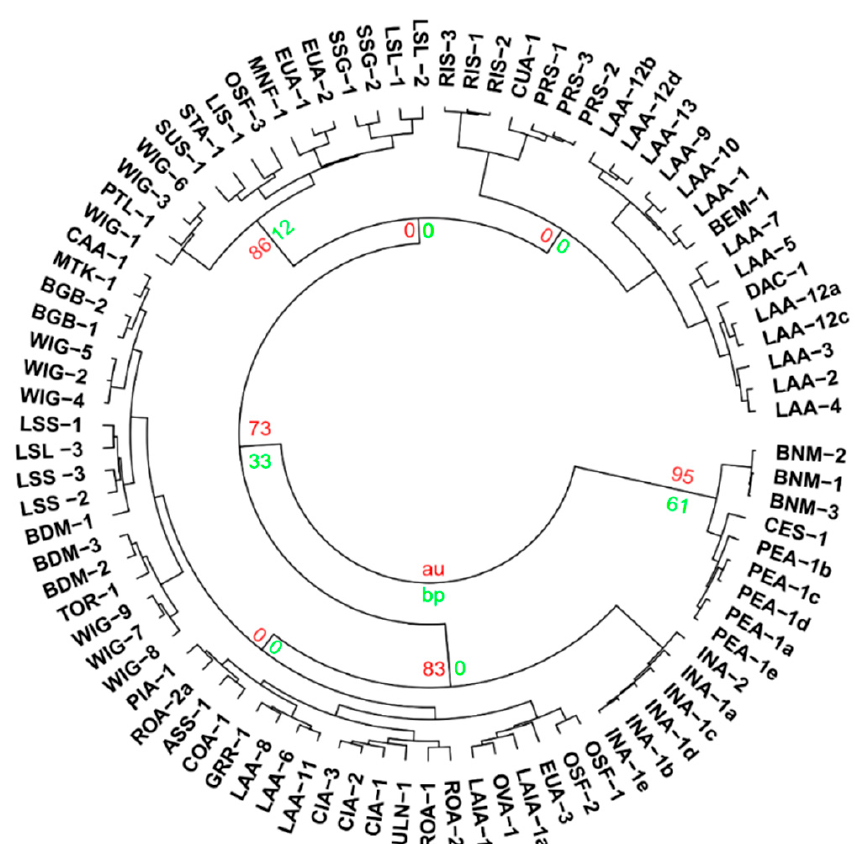
Figure 2. Dendrogram of all essential oil chemical data from the current study and published data [8,13]. BNM = P. sp. Barren Mountain, LAA = P. lanceolata , BEM = P. sp. Blue Mountains, CIA = P. cineolifera , ULN = P. sp. Ulan, COA = P. cotinifolia , OVA = P. ovalifolia (actual), ROA = P. rotundifolia (actual). CES = P. centralis , SUS = P. suborbicularis , STA = P. striatiflora , MNF = P. sp. Minyon Falls, OSF = P. sp. Olney State Forest, CUA = P. cuneata , PRS = P. prunelloides, LIS = P. lithospermoides , RIS = P. ringens , INA = P. incisa , CAA = P. caerulea , BGB = P. sp. Baking Board, TOR = P. sp. Thredbo River, GRR, P. sp. Gibraltar Range, ASS = P. aspalathoides , PIA = P. sp. Piliga, DAC = P. sp. Dandarha Creek. PEA = P. petraea . LSL = P. lasianthos subsp. lasianthos , LSS = P. lasianthos subsp. suborbicularis , EUA = P.